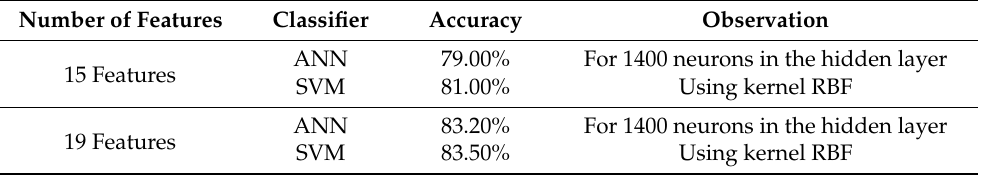
Table 2. Results for experiments with ANN and SVM.